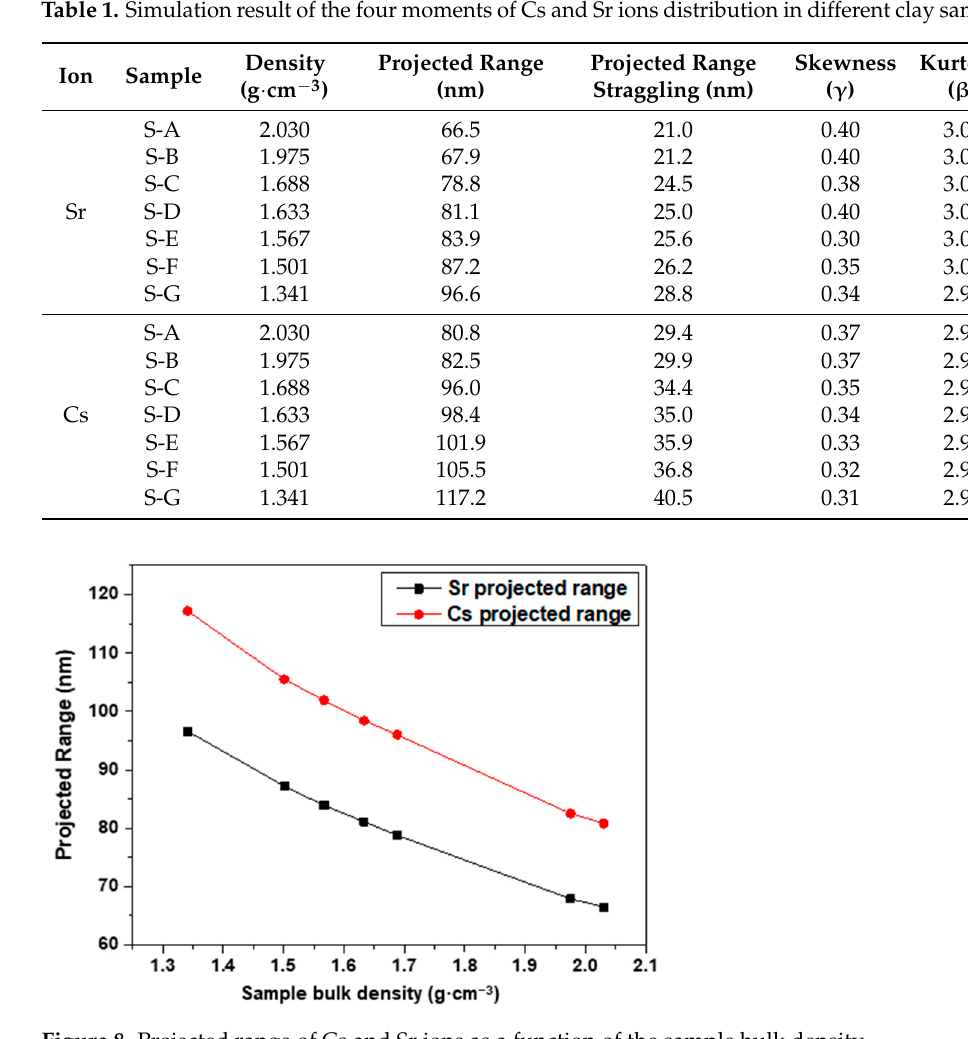
Figure 8. Projected range of Cs and Sr ions as a function of the sample bulk density.